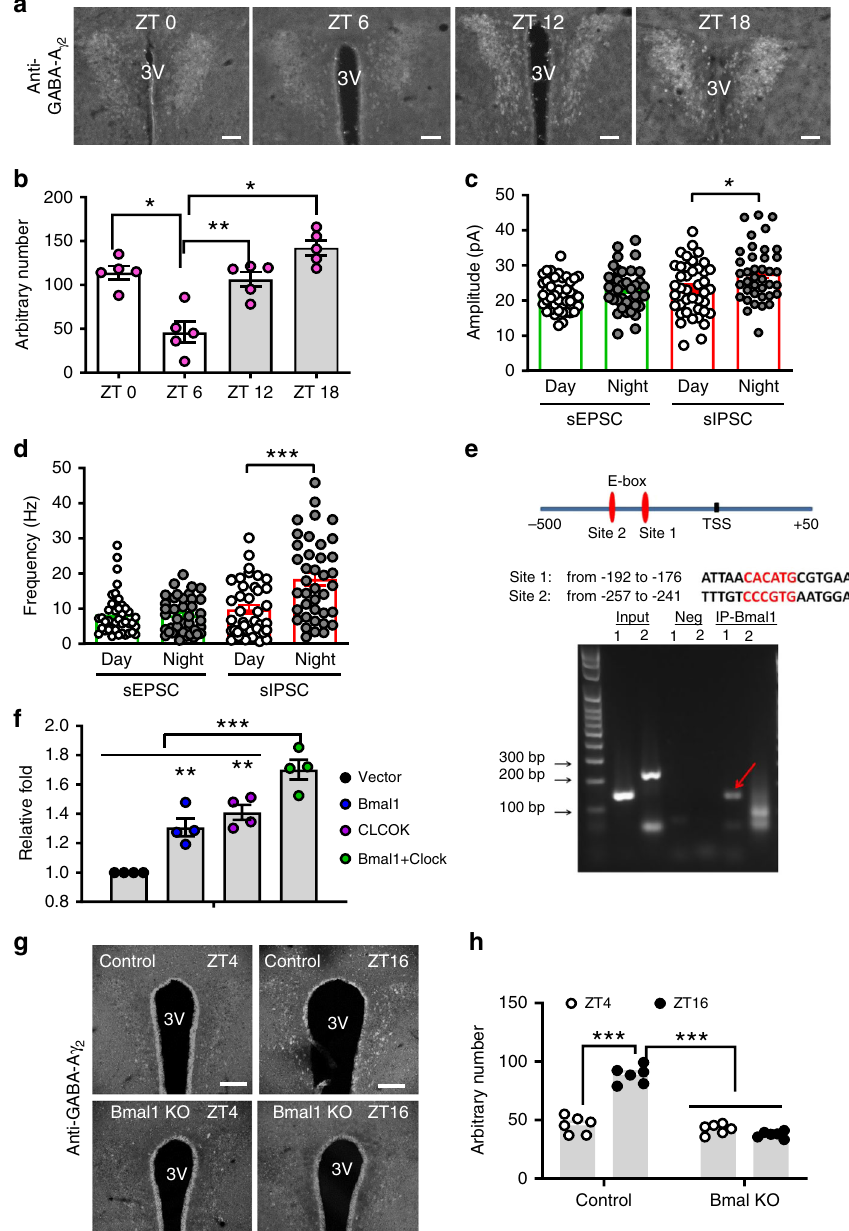
Fig. 4 Diurnal expression and function of PVH GABA-A γ 2 subunit in the PVH. a Immunostaining of PVH GABA-A γ 2 subunit expression at ZT0, 6, 12, and 18 in wild type mice (8 – 10 weeks old) and ( b ) the quanti fi cation data (one-way ANOVA, n = 5 each, F (4, 12) = 0.2464, * p = 0.0458 ZT0 vs ZT6, ** p = 0.0026 ZT6 vs ZT12, * p = 0.0258 ZT6 vs ZT18), showing diurnal expression pattern of γ 2 subunit. Quanti fi cation of the amplitude ( c , n = 41 for Day and 39 for Night, unpaired two-tailed Student ’ s t- test, t = 2.553, d.f. = 78, * p = 0.0126) and frequency ( d , n = 41 for Day and 39 for Night, unpaired two-tailed Student ’ s t- test, t = 3.969, d.f. = 78, *** p = 0.0002) of sIPSCs and sEPSCs recorded from PVH neurons during day and night periods (4 – 6 weeks old). Data are represented as mean ± SEM. Scale bars: 100 μ m. PVH paraventricular hypothalamus, 3V the third ventricle, ZT zeitgeber time. e Identi fi cation of two potential BMAL1-binding E-box motifs in the promoter region of the GABA-A receptor γ 2 gene (top) and results of the ChIP analysis showing speci fi c binding of BMAL1 with the site 1 E-Box (arrow). f Results from a luciferase assay showing BMAL1 and CLOCK increased the γ 2 promoter activity alone and synergistically (one-way ANOVA, n = 4 each, F (3, 12) = 30.93, ** p = 0.006 Vector vs BMAL1, ** p = 0.0006 Vector vs CLOCK, *** p < 0.0001 Vector vs BMAL1/CLOCK). g Representative γ 2 immunostaining from matched PVH sections harvested at day (ZT4) and night (ZT16) in control and BMAL1 deletion mice with AAV-Cre-GFP delivery to the bilateral PVH. h Comparison of average γ 2 expression in the PVH between day and night in controls and the BMAL1 deleted group (two-way ANOVA, n = 6 each, F (1.963, 9.814) = 95.53, *** p < 0.0001 Control ZT4 vs ZT16, p = 0.2775, BMAL1 ZT4 vs ZT16). All data presented at mean ± SEM. Source data are provided as a Source Data fi